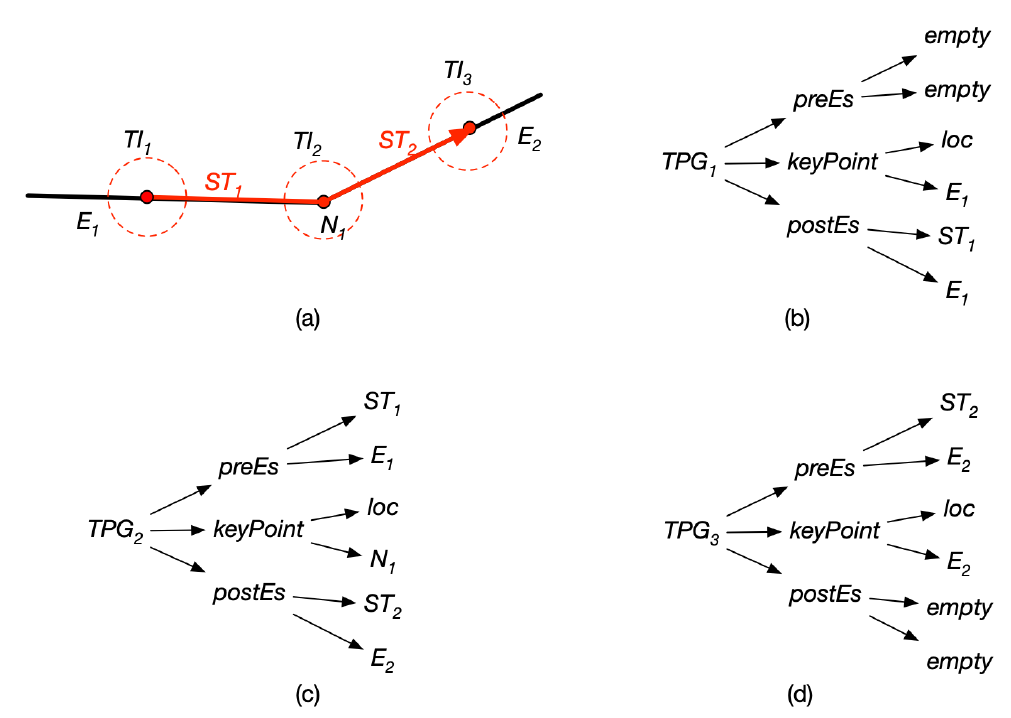
Figure 3. Topological part groups of trajectory-element intersections. ( a ) Three typical topological part groups of trajectory-element intersections; ( b ) a topological part group at the starting point of the trajectory; ( c ) a topological part group at the ending point of the trajectory; ( d ) a topological part group at interval of the